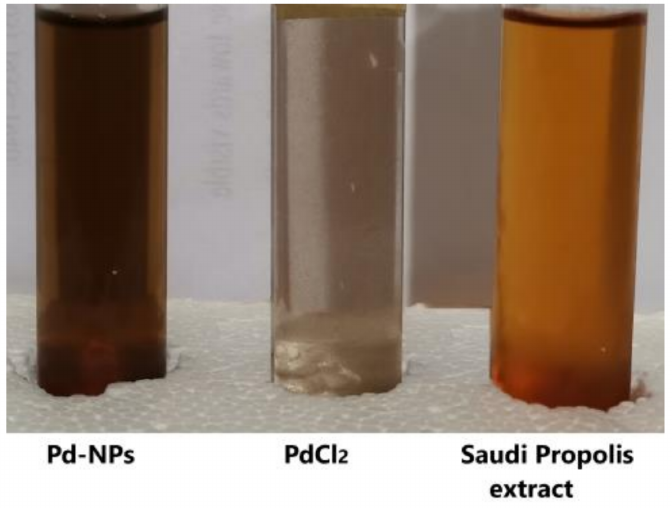
Figure 1. The photographs of the elements that interact with each other and the finished product (Pd-NPs).